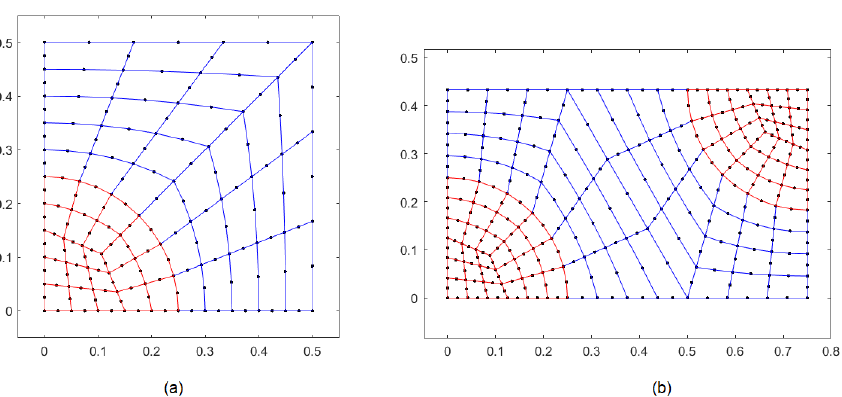
Figure 2. 8-node quadrilateral meshes: ( a ) square cell distribution, ( b ) hexagonal cell distribution. Linear and quadratic FEM formulations are carried out throughout this investigation.